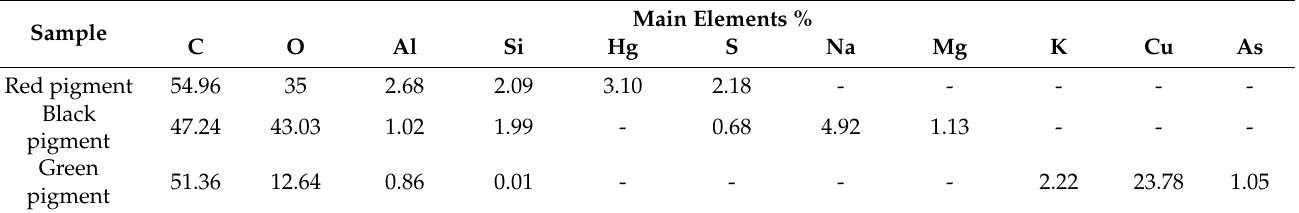
Figure 7. Raman spectra of the pigments. ( a ) Red pigment of Sample 2; ( b ) black pigment of Sample 3; ( c ) green pigment of Sample 4. Table 2. Elemental composition of the